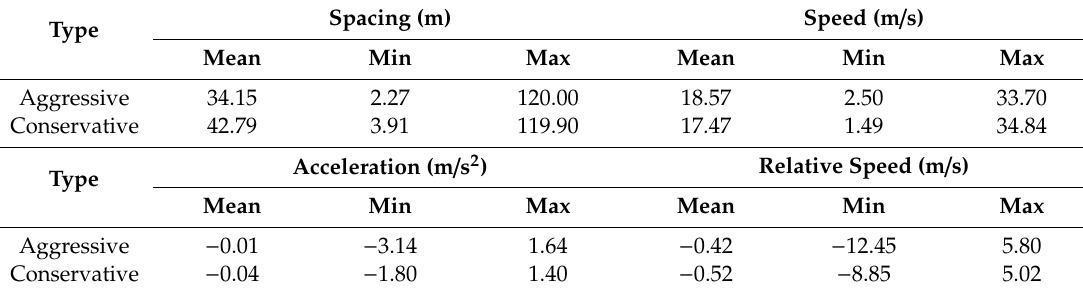
Figure 10. Rule of changes for acceleration in di ff erent relative speed ranges for the two groups of drivers. Table 1. Descriptive statistics of the two groups of drivers in